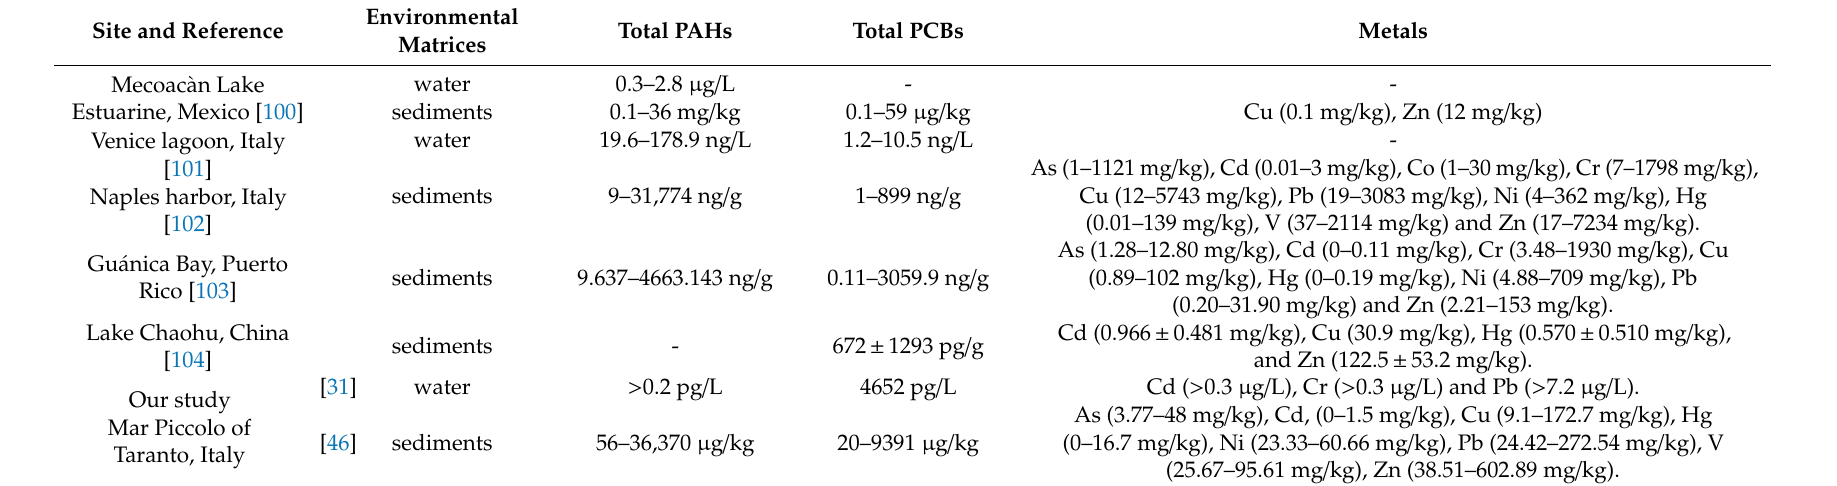
Table 8. Comparative sediment and water concentrations of PAHs, PCBs and Metals in marine basins worldwide.